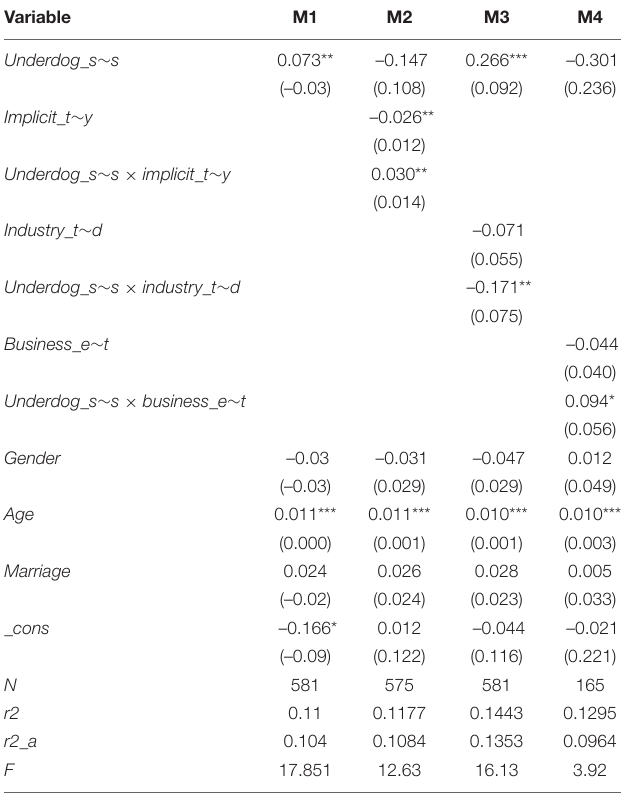
TABLE 4 | Regression analysis results of underdog status, three moderating variables and entrepreneurial resource efficiency (CLDS data).